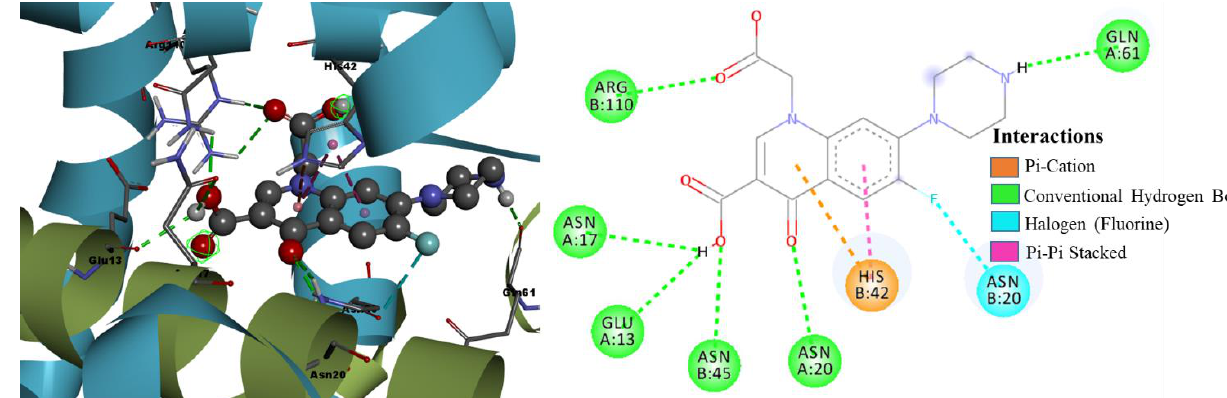
Figure 10. Binding mode conformation and molecular interactions of compound 7g in the active site of S. epidermidis TcaR. The left and right figures represent the molecular interactions in 3D and 2D, respectively. The compound 7g is shown in the ball-stick model, and the key interacting residues are shown as grey sticks. Table 2. Molecular docking results of selected dataset against S. epidermidis TcaR.